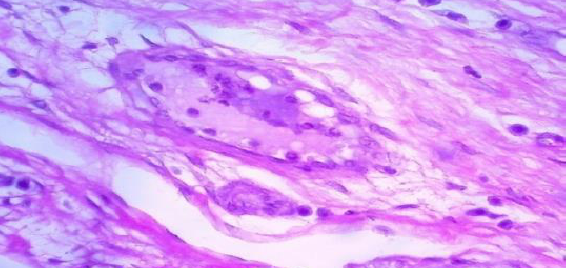
Figure, 19: Tracheal defect at 60 postoperative day in G1 infiltration of inflammatory cells (lymphocyte (A), macrophage (B), plasma cell(C) ( H&E X40).